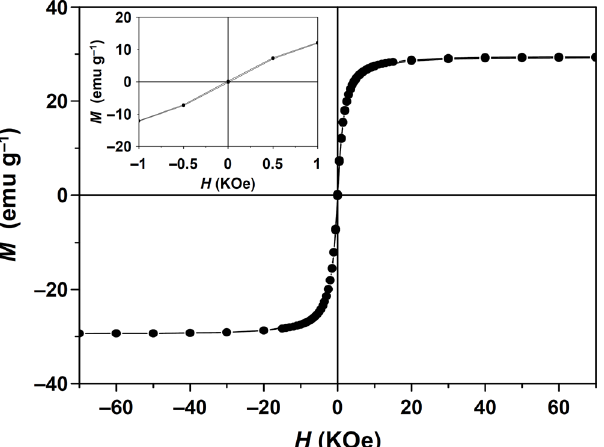
Figure 4. Field-dependent magnetization curves of Au@hmC-FeCo/GCs measured at 300 K. The inset shows the loop on an enlarged x-axis scale.